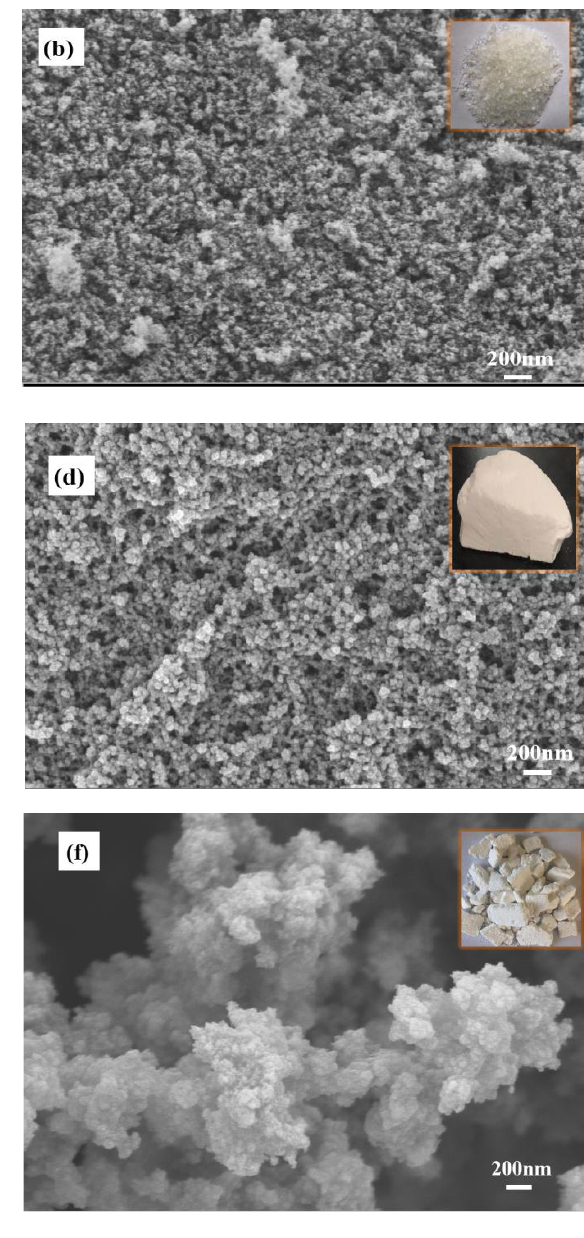
Figure 4. SEM microstructures and morphologies of the different V/W samples ( a ) VW-0.2, ( b ) VW- 0.4, ( c ) VW-0.6, ( d ) VW-0.8, ( e ) VW-1.0, and ( f )